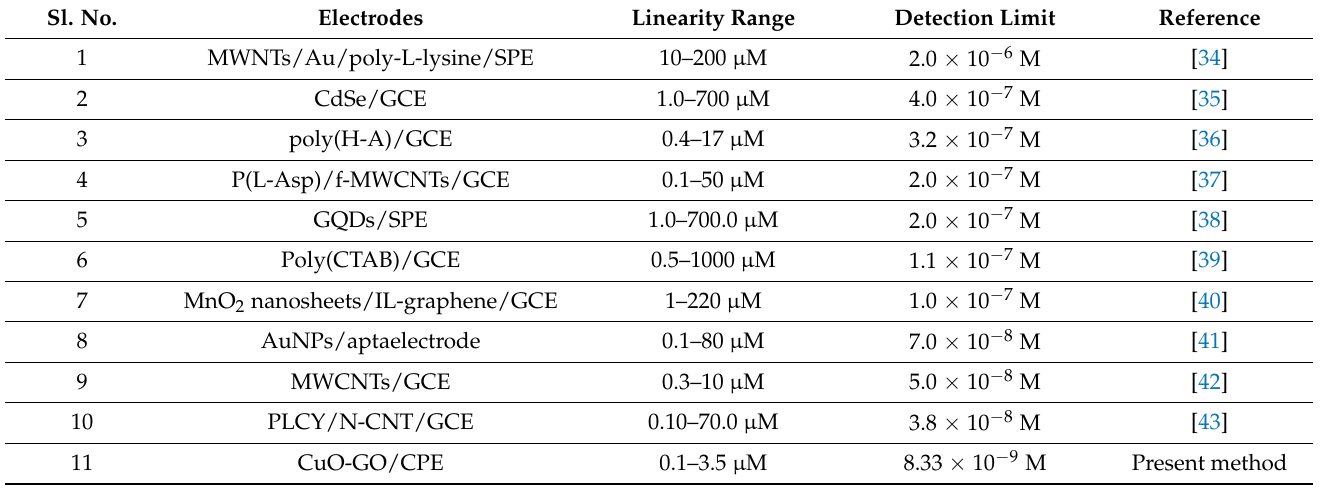
Figure 7. ( A ) Differential pulse voltammograms of the THP in the CuO-GO/CPE modified electrode; t acc = 10 s. ( B ) Calibration plot of the peak current against the concentration. Table 1. Comparison of detection